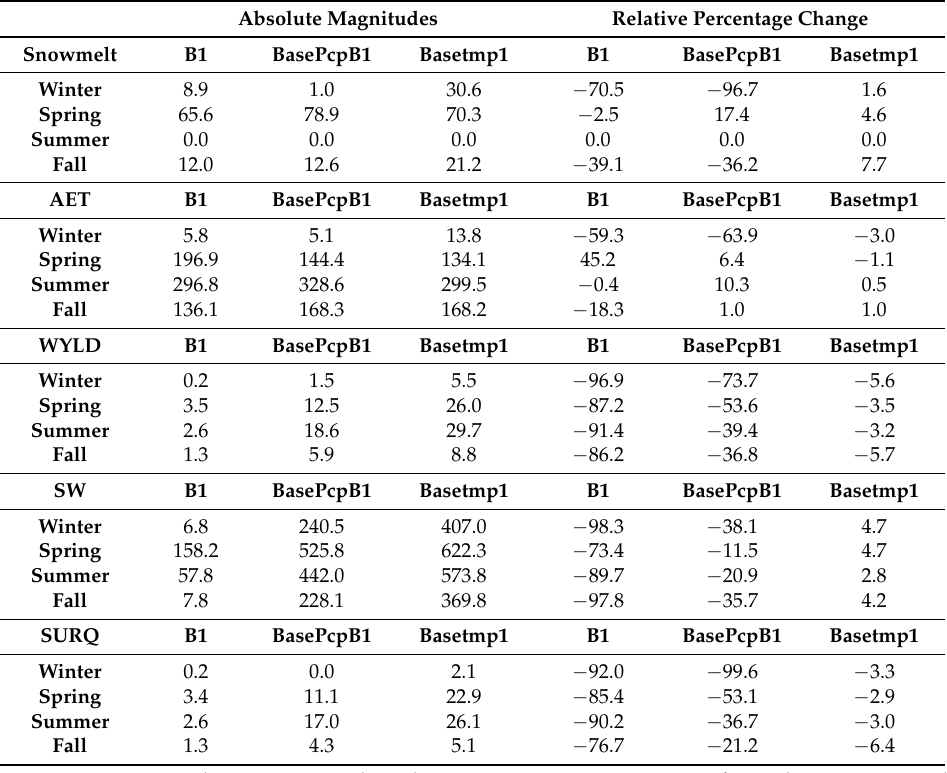
Table A7. Seasonal Variations seen in scenarios B1 (with the combined effect of change in precipitation and temperature), BasePcpB1 (change in temperature), and Basetmp1 (change in precipitation) for the period from 2046–2065. The relative percentage change is with respect to the baseline.